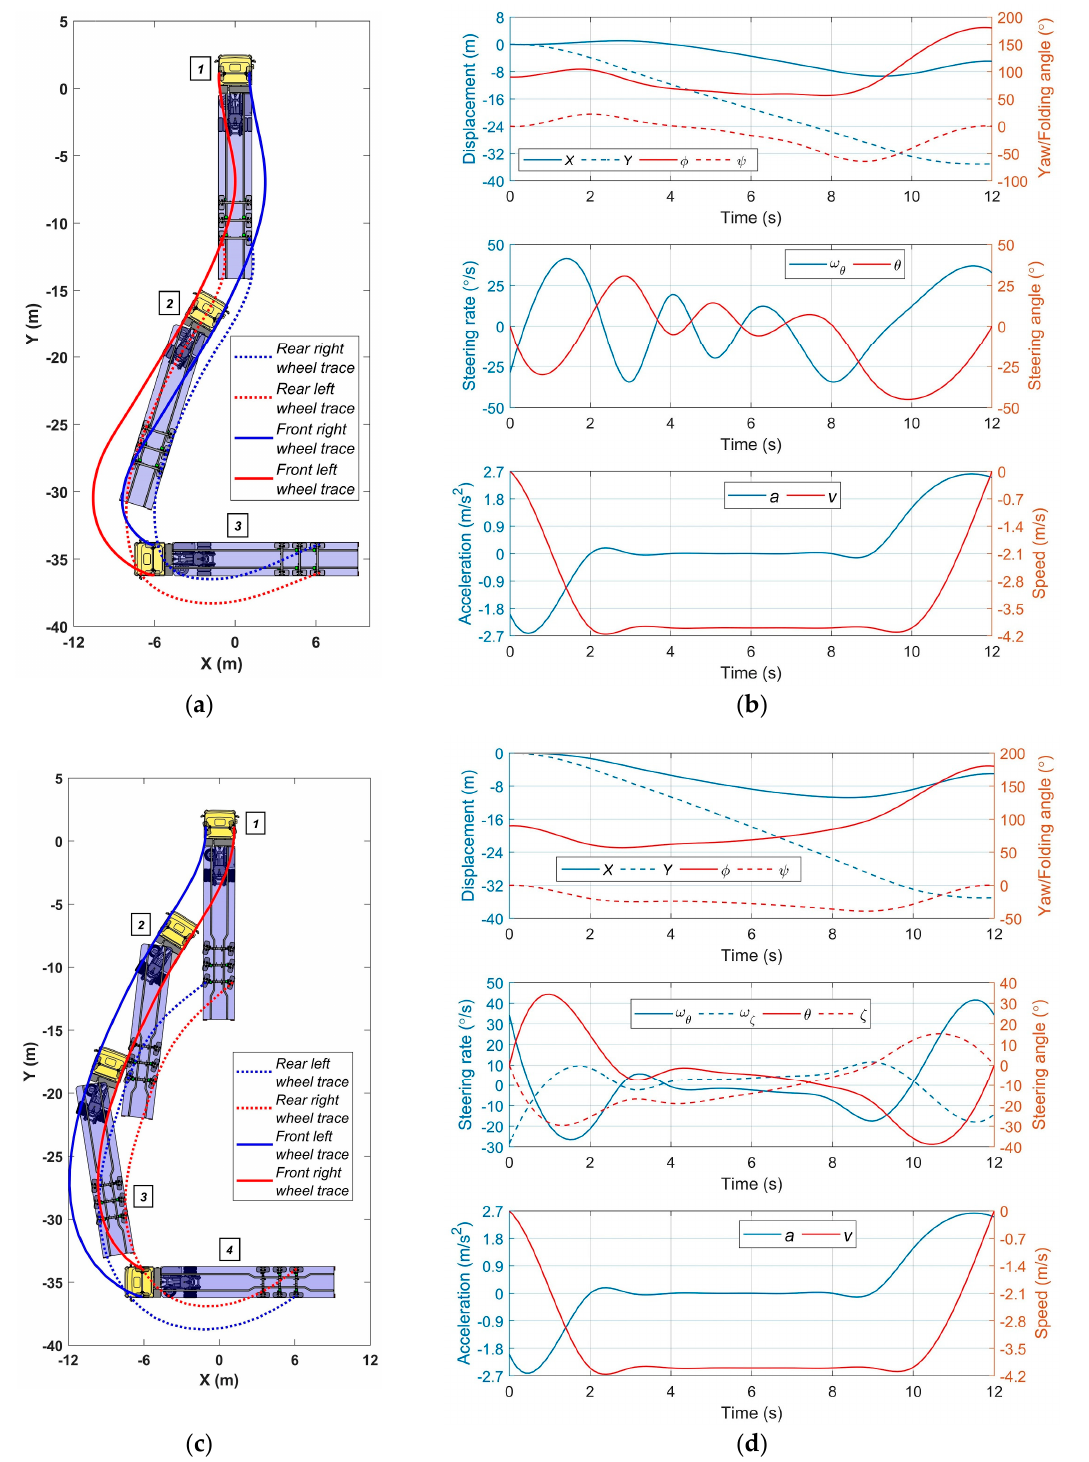
Figure 7. Simulation results for the docking of articulated vehicles: ( a ) Position and trajectory (conventional TSV); ( b ) Basic parameters (conventional TSV); ( c ) Position and trajectory (TSV-SSA); ( d ) Basic parameters (TSV-SSA).